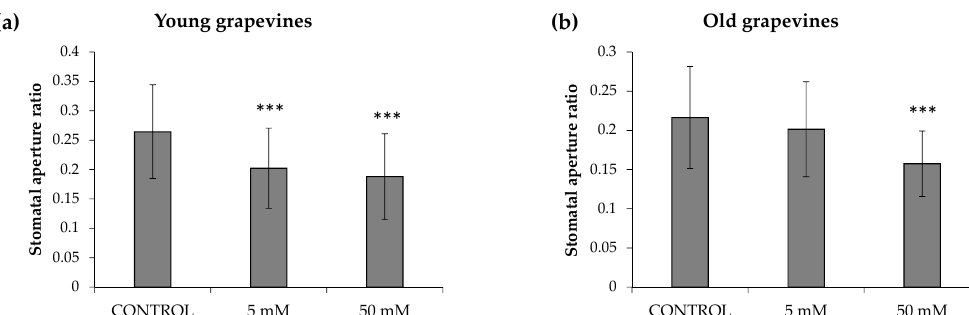
Figure 1. Effect of ( Z )-3-hexenyl butyrate (HB) on stomatal aperture ratio of Vitis vinifera L. cv Bobal leaves. Stomatal aperture mean values ± SE are shown of one representative experiment. Leaves from young grapevines ( a ) and old grapevines ( b ) were collected 24 h after treatments at different HB concentrations. Asterisks (***) indicate statistically significant differences between control and HB-treated grapevine plants at each concentration with p < 0.001.